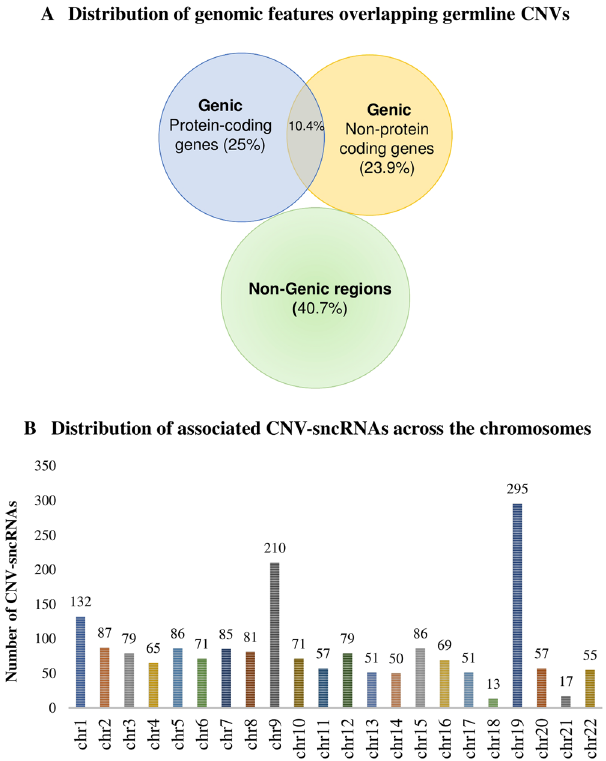
Figure 2. Genome wide distribution of germline CNVs. ( A ) Distribution of genomic features overlapping germline CNVs. Figure shows a Venn diagram of the genome wide distribution of germline CNVs associated (q < 0.05) with breast cancer. Represented genic regions were: protein coding (25%) and non-protein coding genes including pseudogenes and small and long non-coding RNAs (23.9%). An overlap of these regions (10.4%) capture non-coding RNAs originating from the intronic regions of the coding genes. 40.7% of CNVs do not show embedded genes (genome build hg19), hence labelled as non-genic regions. ( B ) Distribution of associated CNV-sncRNAs across the chromosomes. Figure illustrates the distribution of breast cancer associated CNVs (q < 0.05) harboring small non-coding RNA genes (miRNA, piRNA, tRNA and snoRNAs) for all